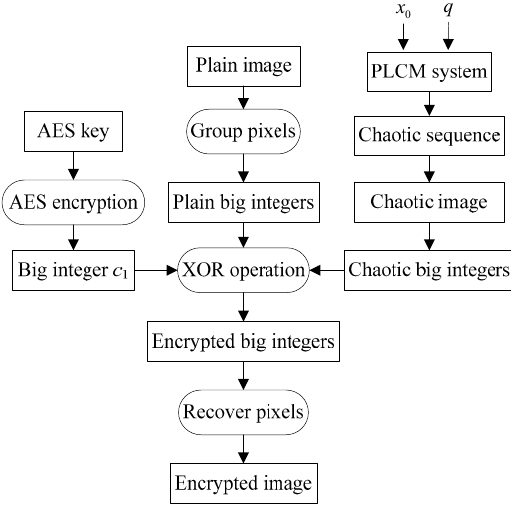
Figure 1. The encryption flowchart of the proposed algorithm.